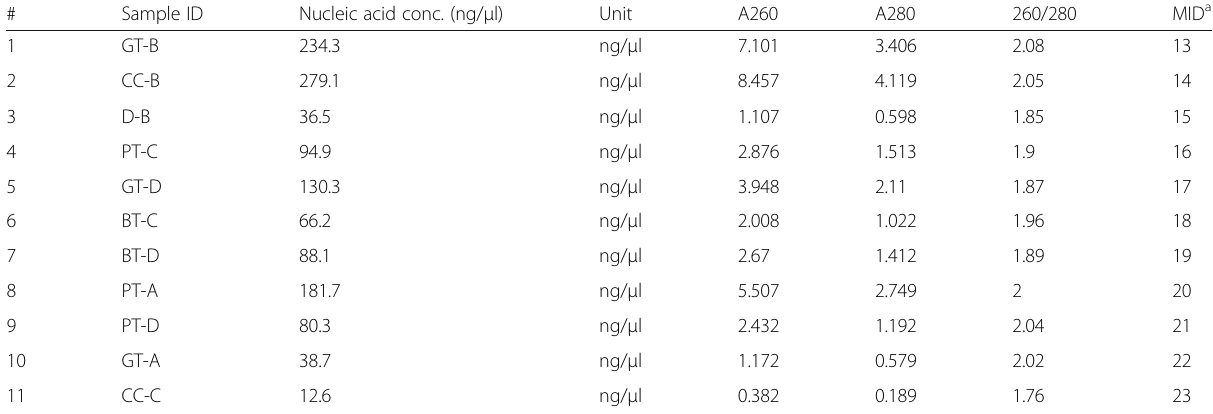
Table 2 The concentration and quality of mRNA as determined based on absorbance at 260 nm and 280 nm using a Nanodrop